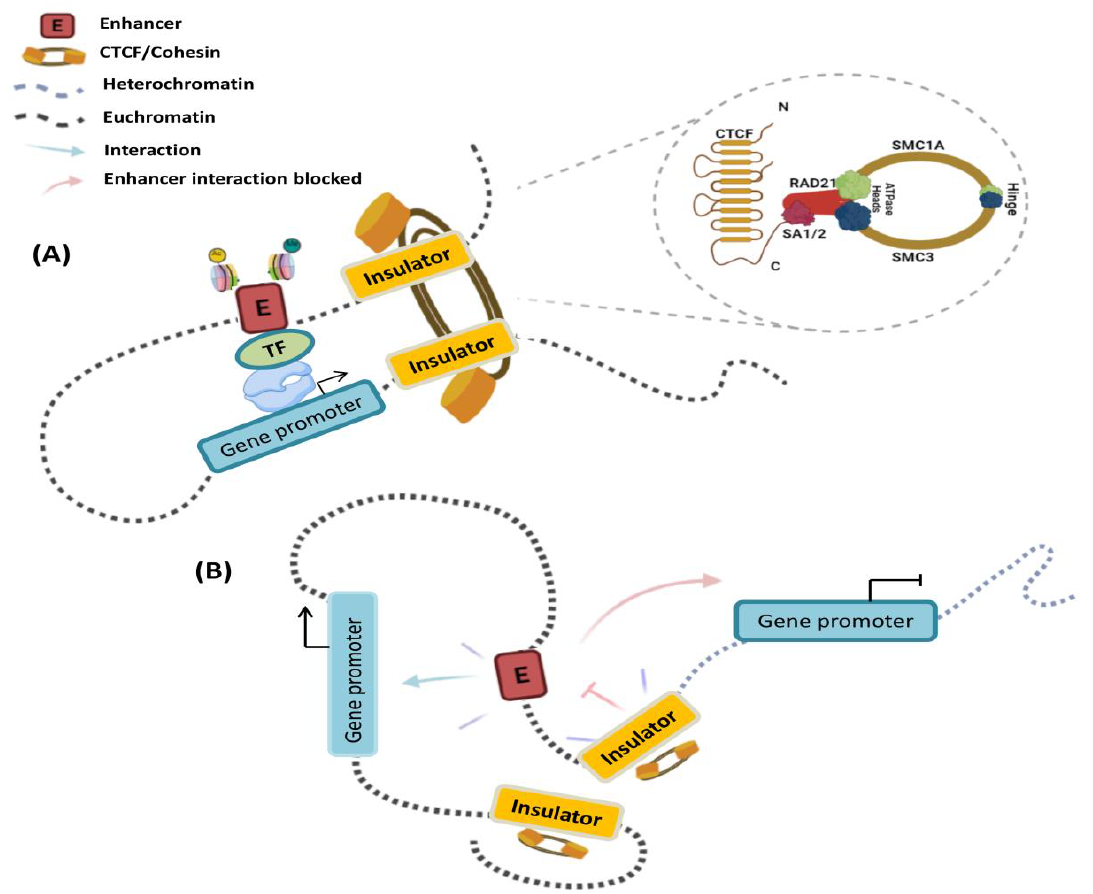
Figure 1. Cis-regulatory elements (CREs) in gene promoters activate or repress gene expression in different cellular contexts: ( A ) A model of transcriptional activation by chromatin looping and enhancers is shown. The CTCF — cohesin interaction promotes the creation of chromatin loops. In somatic cells, this is organized into four core sub-units: structural maintenance of chromosomes protein 1A (SMC1A), SMC3, double-strand-break repair protein rad21 homologue (RAD21), and either cohesin component SA-1 (STAG1) or SA-2 (STAG2). Transcription factors (TFs) bind specifically to sequences of cis-regulatory elements and initiate transcription. ( B ) An insulator can block the spread of heterochromatin and can selectively protect enhancer — promoter interactions inside the chromatin loop. Furthermore, an enhancer-blocking insulator complex restricts the activity of a distal enhancer in an orientation-dependent way.